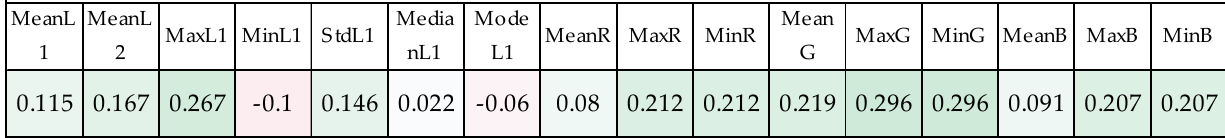
Figure 17. The value of the correlation coefficient between tie-point number and the other F-point features. Further verification of the correlations for all cases between the number of tie-points and the F-points’ features (Figure 17) demonstrated a rather low Pearson correlation coefficient, of no more than +/ − 0.30. The low dependency demonstrates a certain trend that, together with the earlier analysis of the NT-p and XYZ total error dependency, allows for the statement that an increase in the number of tie-points mostly depends on the MeanG feature, which was earlier confirmed. This allows for the statement that a higher MeanG value will minimise the XYZ total error, thereby having a positive impact on the geometry and quality of the photogrammetric study. Following this conclusion, the correlation values were divided and assigned to the given study type, as presented in Figure 18.